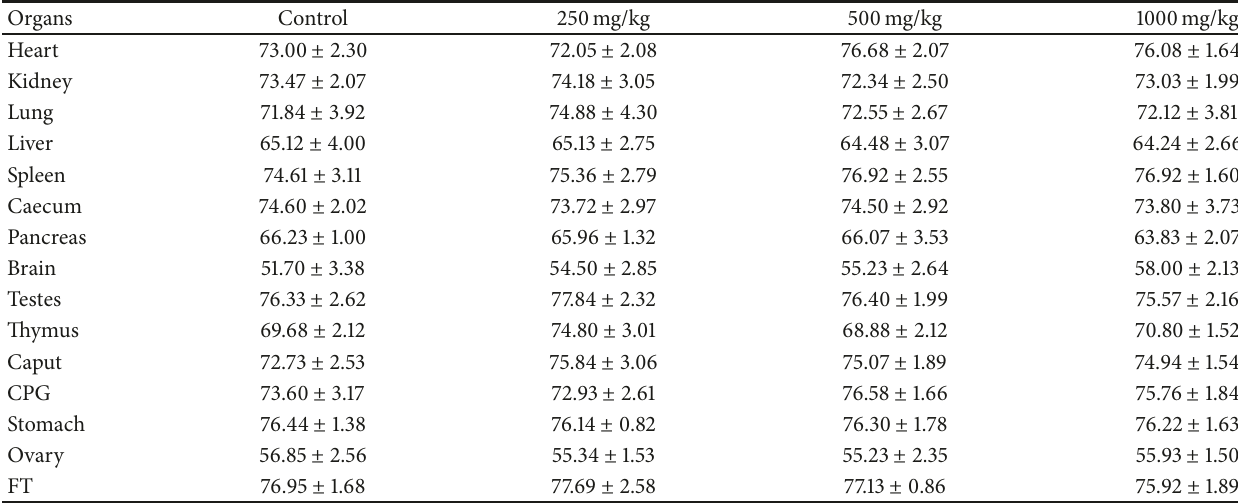
Table 3: The effects of different concentrations of methanolic extract of pomelo on the percentage of water content of different organs.